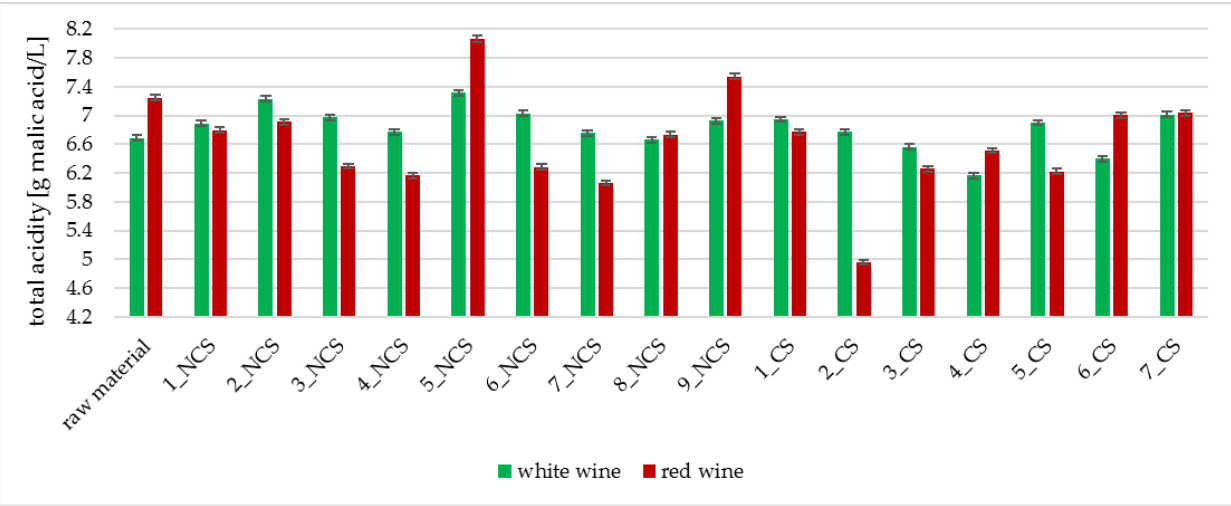
Figure 4. Total acidity of white and red wines.